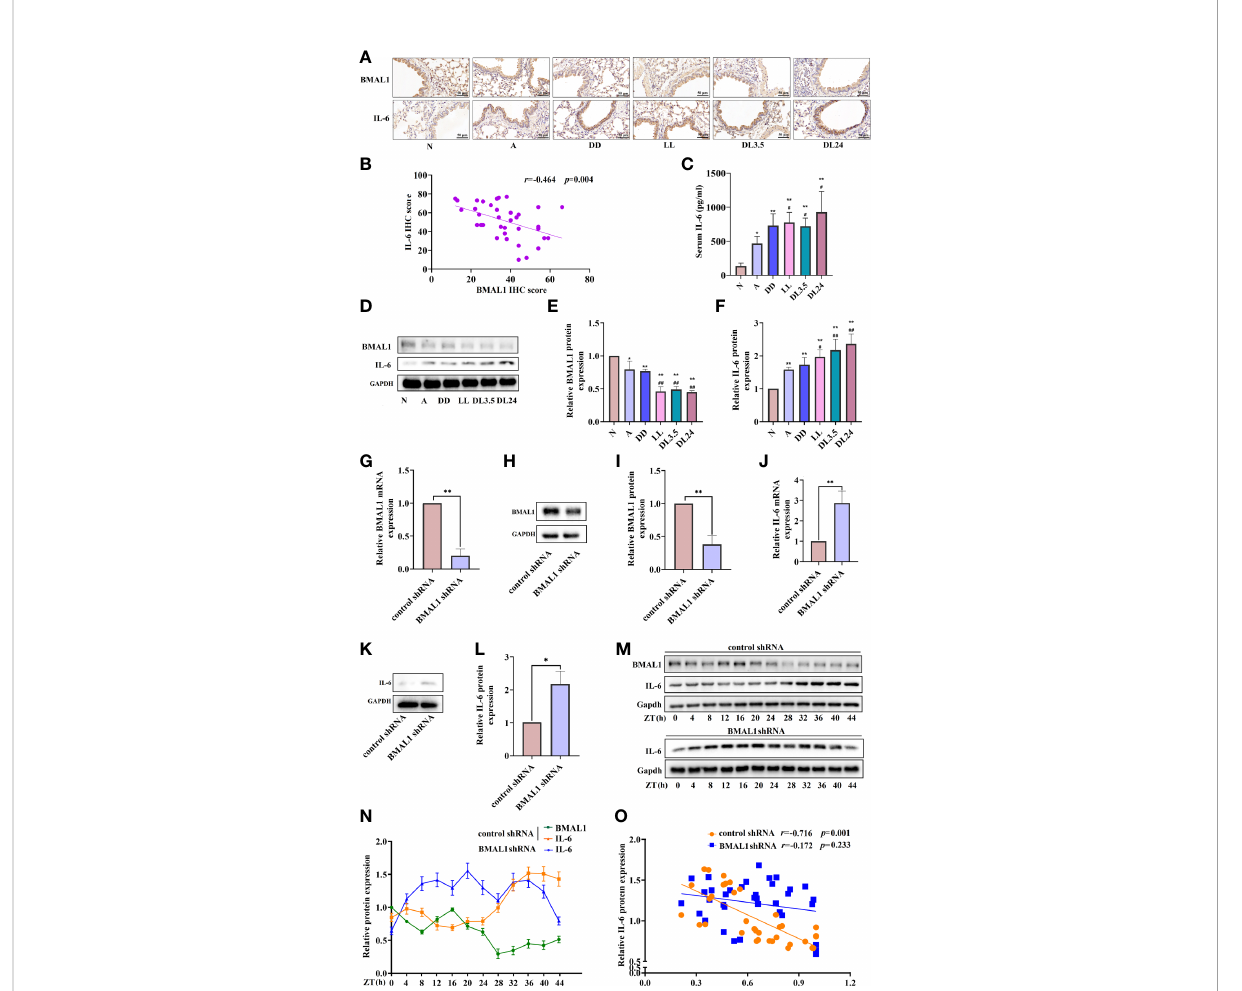
FIGURE 4 BMAL1 regulates the expression and rhythm fl uctuations of IL-6. (A) Immunohistochemistry staining of BMAL1 and IL-6 in the mouse lung tissue of each group. Magni fi cation: 200×. Scale bar: 50 m m. (B) Correlational analyses between BMAL1 and IL-6 protein expression levels in mouse lung tissue. (C) ELISA analysis of serum IL-6 in the mouse lung tissue of each group. (D) Western blot analysis of the protein levels of BMAL1 and IL-6 in the mouse lung tissue of each group. ImageJ software was used to quantify the BMAL1 (E) and IL-6 (F) bands. The mRNA (G) and protein (H) levels of BMAL1 expression in 16HBE cells with BMAL1 shRNA and control shRNA by RT-qPCR and Western blot, respectively. ImageJ software was used to quantify the BMAL1 bands (I) . RT-qPCR and Western blot analysis of IL-6 mRNA (J) and protein (K) levels of control shRNA and BMAL1 shRNA cells. IL-6 bands were quantitatively analysed by ImageJ software (L) . Western blot analysis of the protein levels of BMAL1 and IL-6 in control shRNA and BMAL1 shRNA cells in response to serum shock synchronisation (M) , IL-6 and BMAL1 bands were quantitatively analysed by ImageJ software (N) . (O) Correlational analyses between BMAL1 and IL-6 protein expression levels in control shRNA and BMAL1 shRNA cells. N=control group; A=OVA group; DD=OVA + all-day darkness group; LL= OVA + all-daylight; DL3.5= OVA + 3.5h dark/3.5h light group; DL24= OVA + 24h dark/24h light group; IHC, Immunohistochemistry. Data of animal experiment are presented as the mean ± SEM of 6 mice per group. Data of cell experiment shown are representative data of one out of at least 3 independent experiments. * p < 0.05, ** p < 0.01, compared with the control group or control shRNA cells. # p < 0.05, ## p < 0.01 compared with the OVA group. One-way ANOVA with Tukey ’ s multiple comparison analysis method, and independent samples t-tests, Pearson ’ s correlation coef fi